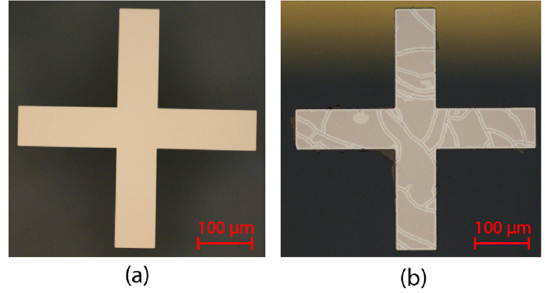
Figure A4. Microscopic image of the photomask alignment mark to indicate the thin film formation quality ( a ) Thin film representing Cr (5 nm)/Ni 80 Fe 20 (60 nm, 120 nm, and 200 nm)/Cr (5 nm). ( b )